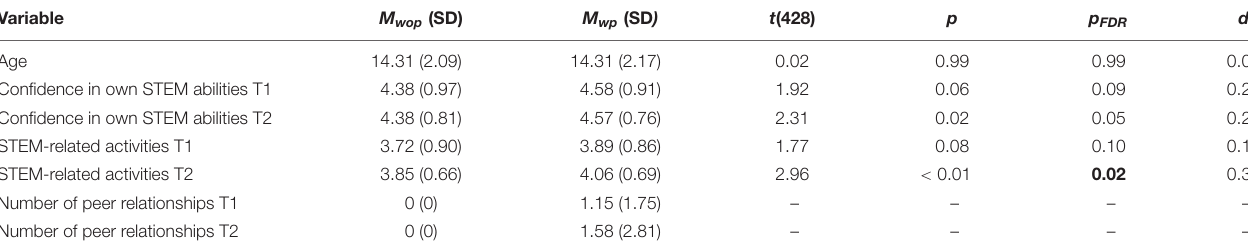
TABLE 2 | Results of the t -tests between mentees and without a peer relationship (wop) with at least one peer relationship (wp). Variable